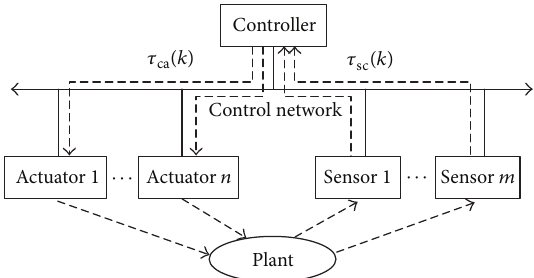
Figure 1: The structure of networked control systems.